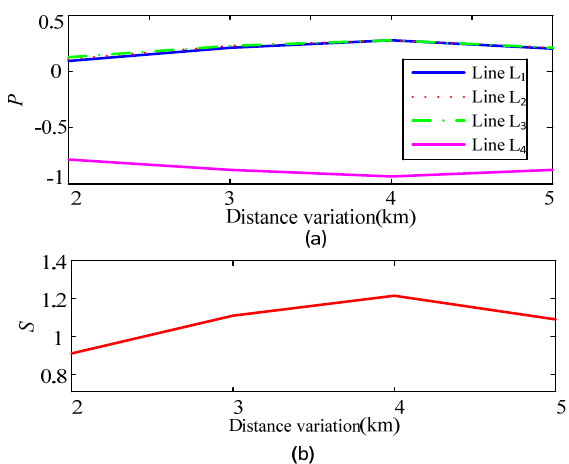
Figure 18. S and P of each feeder with distance variation. ( a ) P of each outgoing line with distance variation; ( b ) S of distance variation.